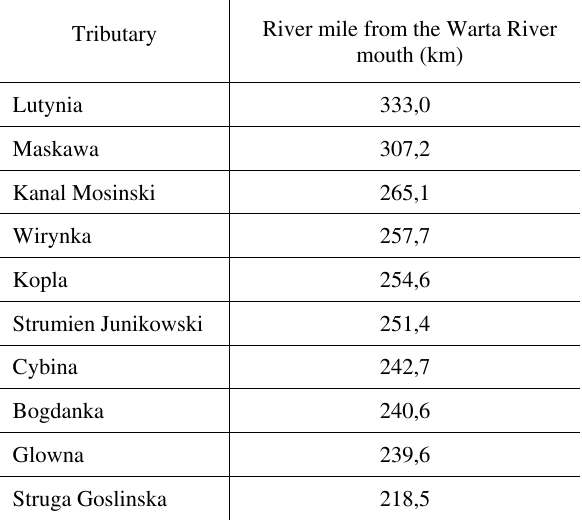
Table 1. Main tributaries of the Warta River included in the